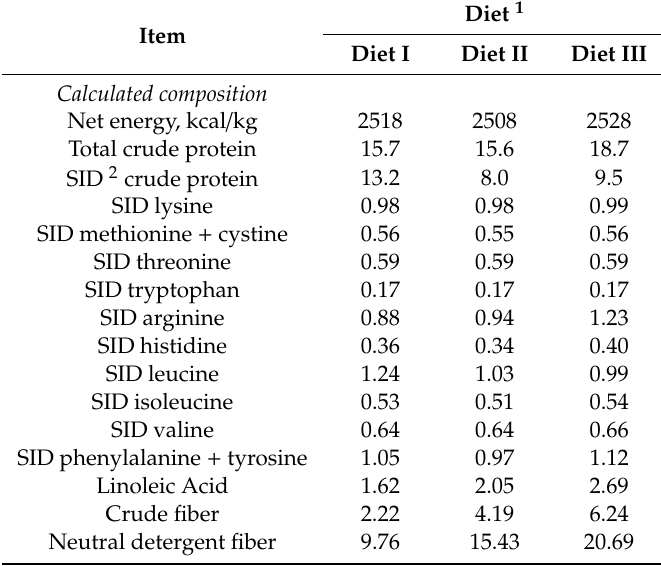
Table 2. Calculated and analyzed nutrient composition (%, or as indicated) of the three experimental diets (as-fed